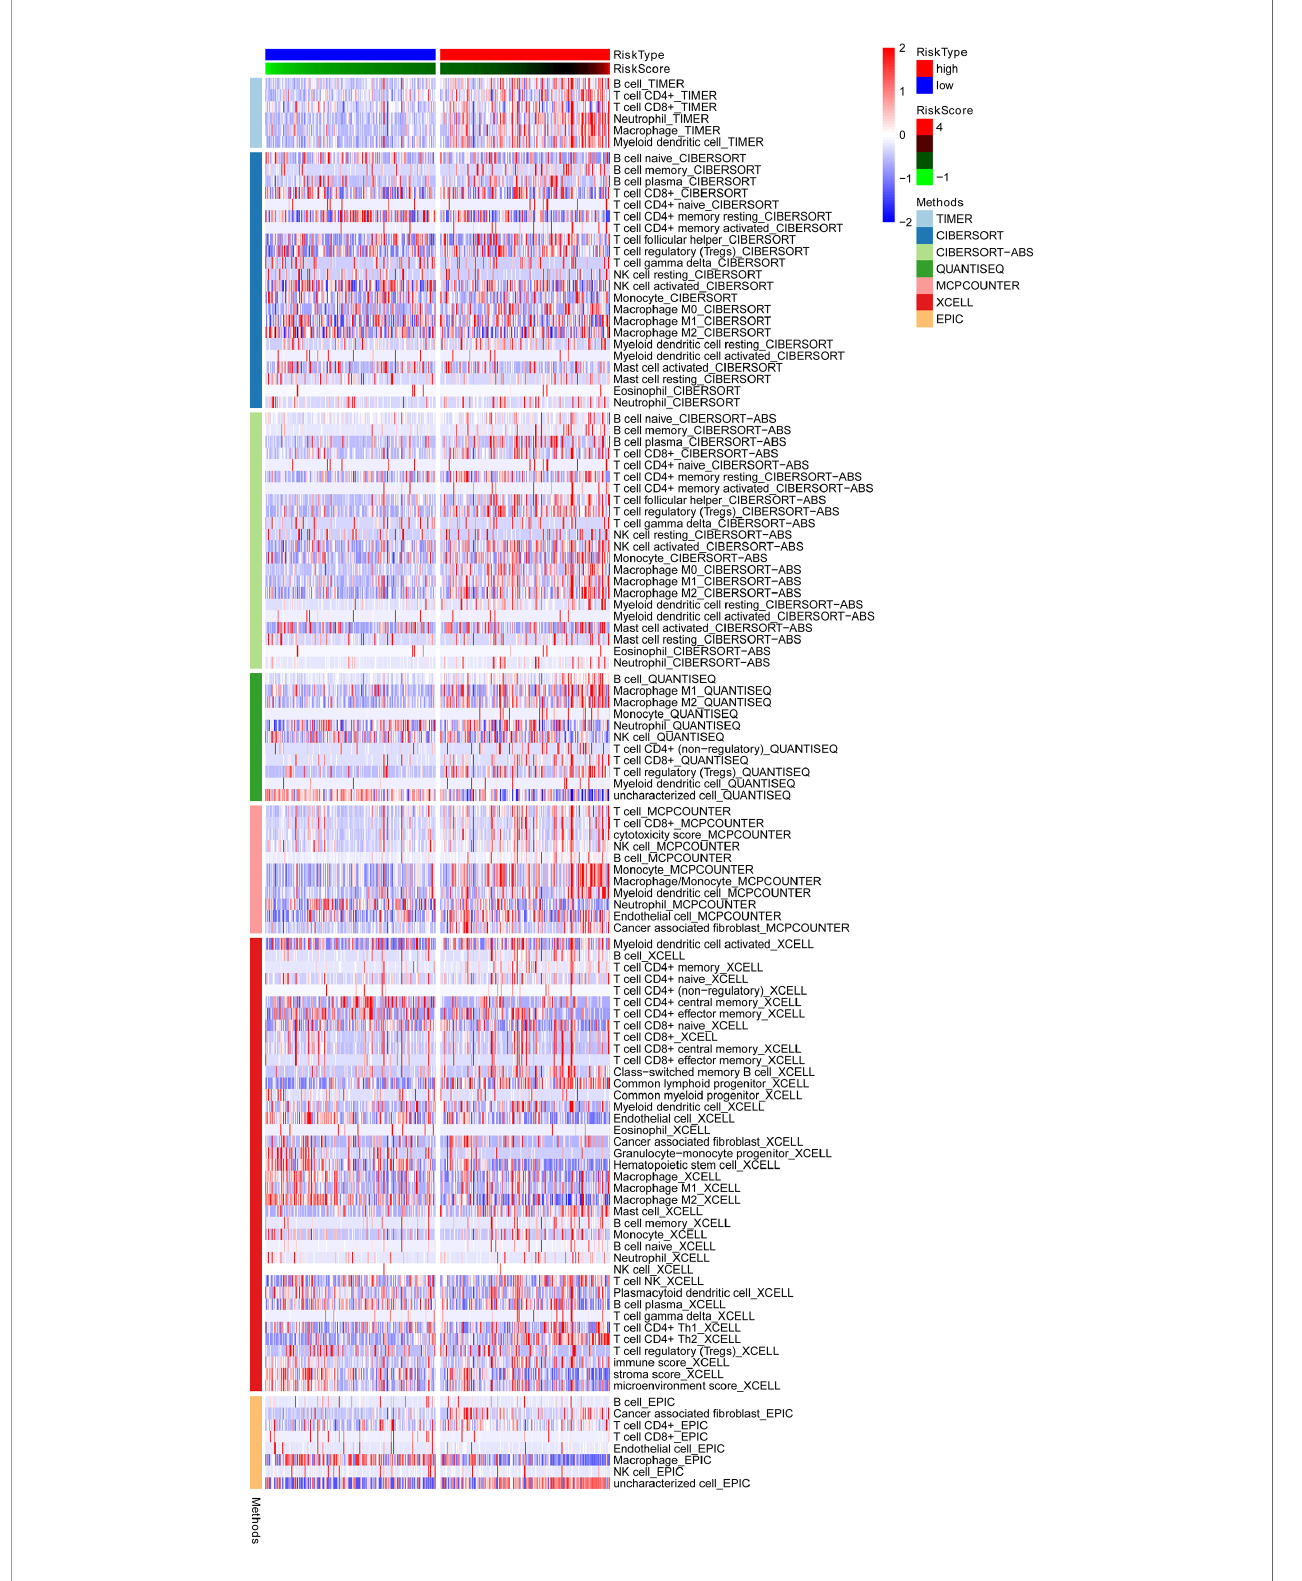
FIGURE 7 | A heatmap showing the immune responses based on different algorithms in the low and high-risk groups and the results demonstrated that most immune cells showed a trend of high expression in the high-risk group when compared to low-risk group. TIMER, tumor immune estimation